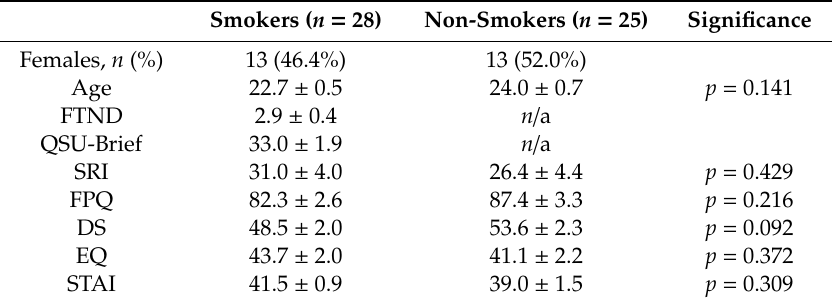
Table 1. Baseline characteristics of the smokers and